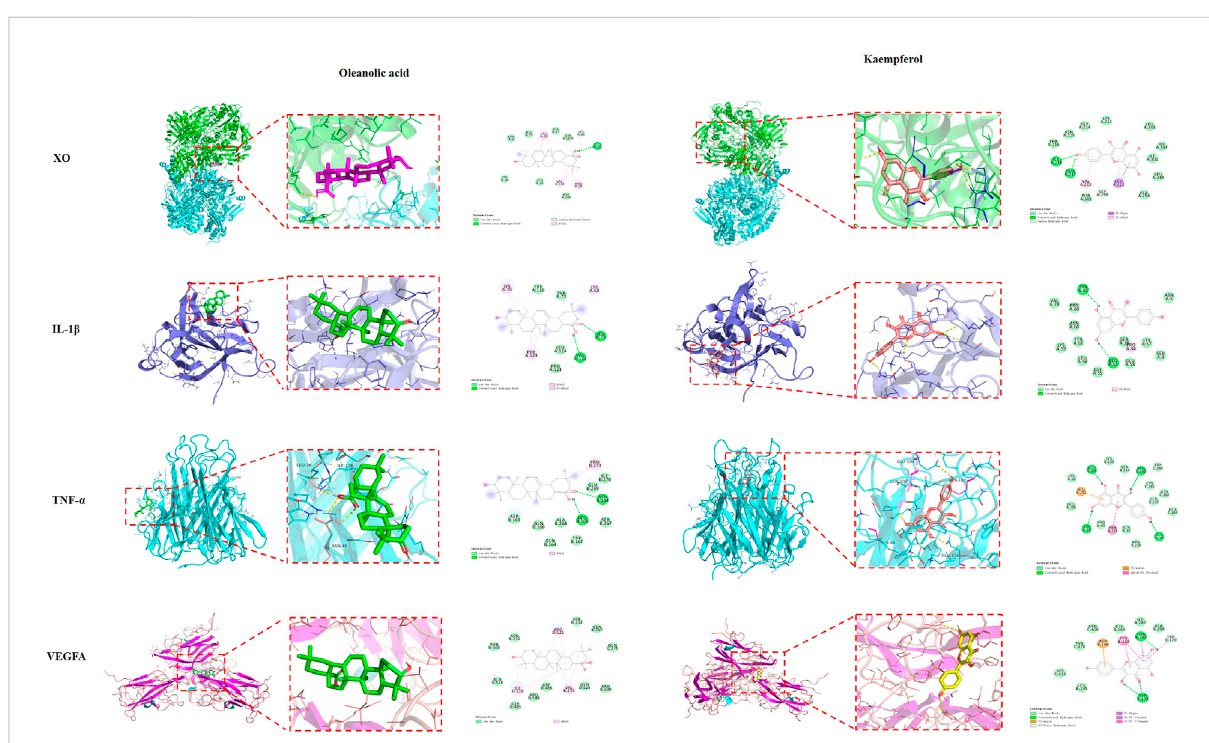
FIGURE 5 Molecular docking of oleanolic acid and kaempferol with TNF- α , IL-1B, VEGFA, and XO, respectively.